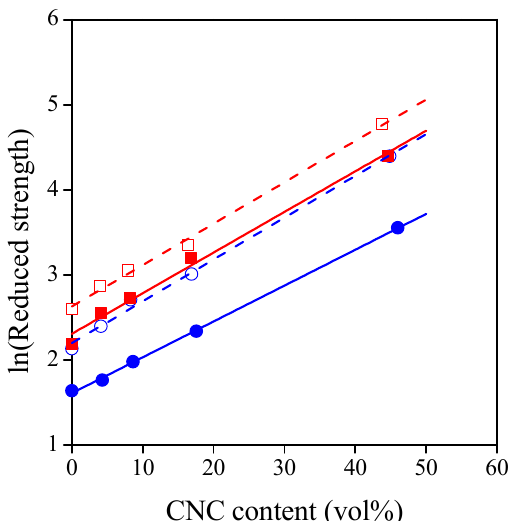
Figure 8. Reduced strength of TPS–CNC composites as a function of CNC content. Reduced strength is defined in Equation (3). Symbols: ( ) 30% glycerol; ( • ) 40% glycerol; ( (cid:3) ) 30% sorbitol; ( (cid:4) ) 40% sorbitol.